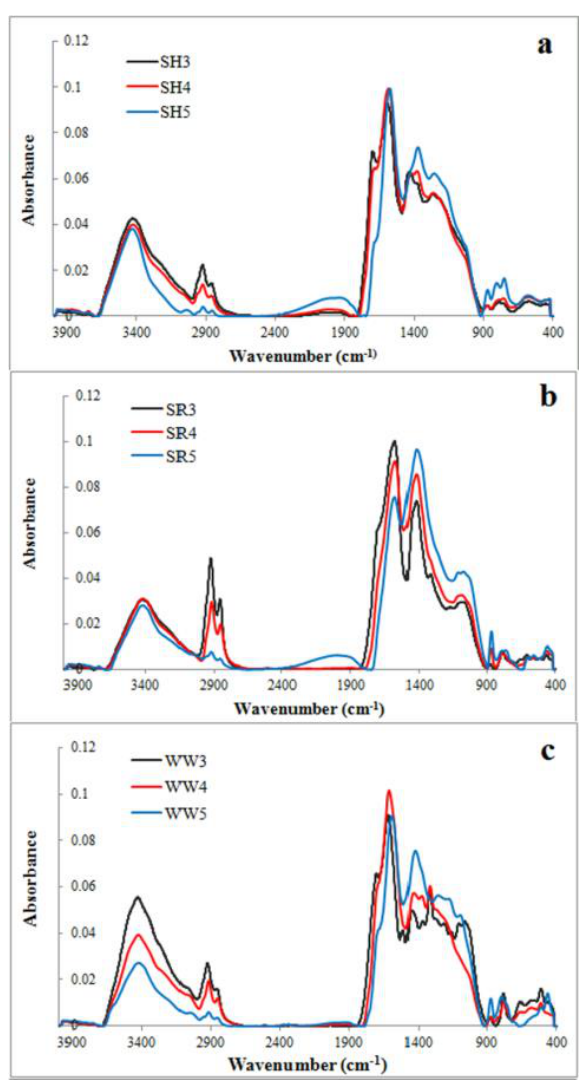
Figure 1. FTIR spectra of experimental biochars ( a ) biochar derived from sunflower husks; ( b ) biochar derived from sunflower husks and rapeseed pomace; ( c ) biochar derived from wood waste): SH3 (sunflower husks, 300 °C), SH4 (sunflower husks, 400 °C), SH5 (sunflower husks, 500 °C), SR3 (sunflower husks + rapeseed pomace, 300 °C), SR4 (sunflower husks + rapeseed pomace, 400 °C), SR5